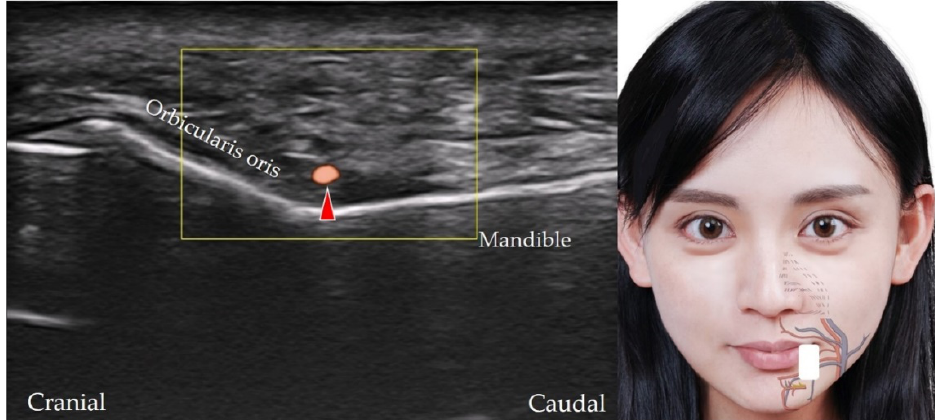
Figure 19. Power Doppler ultrasound imaging of the inferior labial artery (red arrowhead) . White square , footprint of the ultrasound transducer.